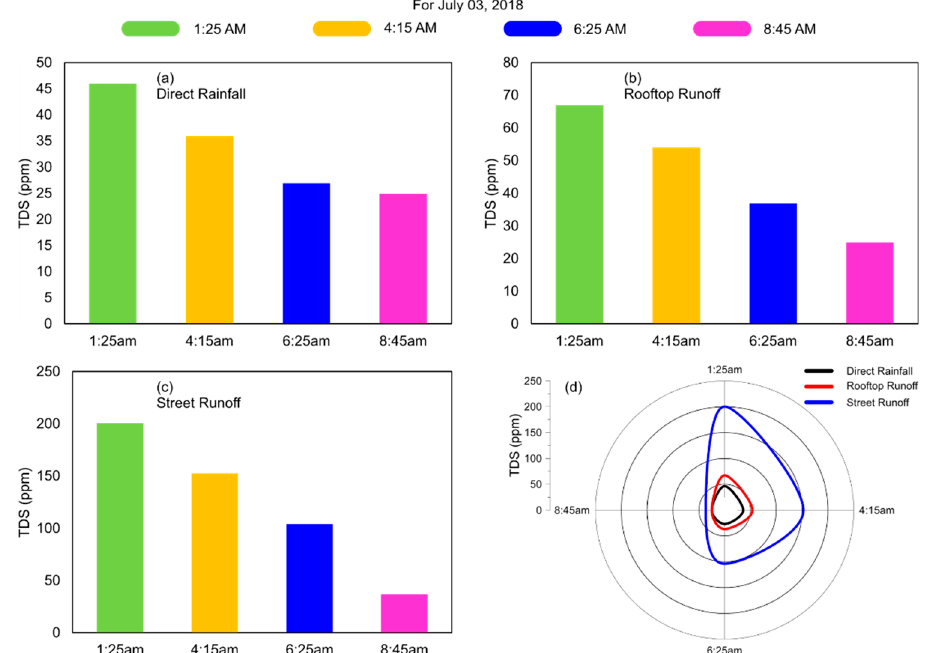
Figure 9. Intraday profile of total dissolved solids (ppm) (on 3 July 2018) at Site S3—Field Research Station Babakwal, Tehsil Ferozewala, District Sheikhupura, where ( a ) represents direct rainfall, ( b ) represents rooftop runoff, ( c ) represents street runoff, and ( d ) illustrates comparative analysis of the three selected categories on polar chart for different rainfall events.